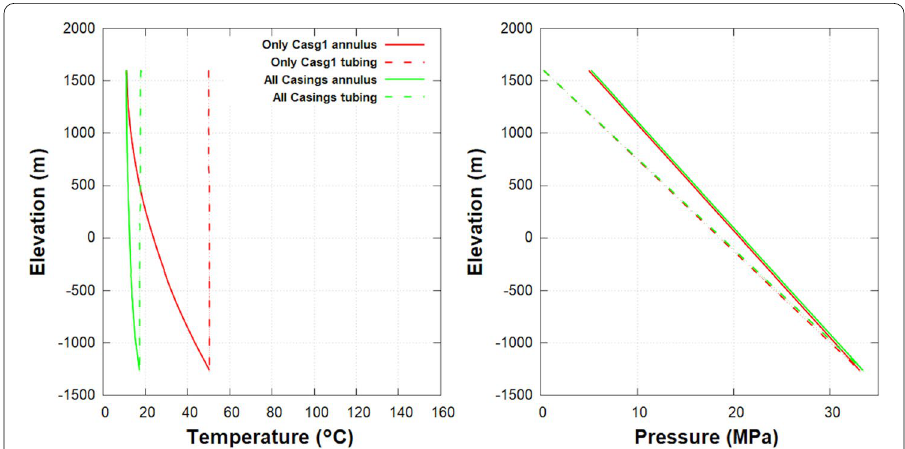
Fig. 7 Thermal conductivity analysis in outer casings for fixed ˙ m = 5 ( kg / s ) over 30 years. Left—temperature vs. elevation for various (cid:31) ( W / mK ) . Right—pressure vs. elevation for various (cid:31) ( W / mK ) . Solid lines represent annulus and dashed lines represent tubing data, respectively. The base-case graph here is highlighted in red